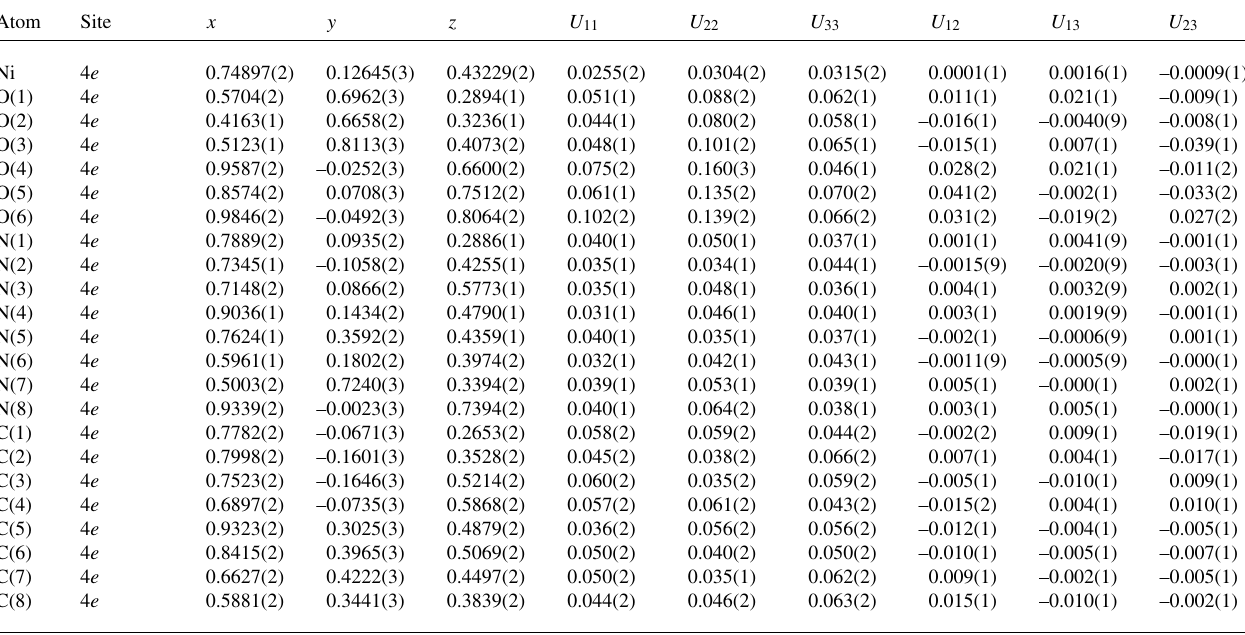
Table 3. Atomic coordinates and displacement parameters (in Å 2 )